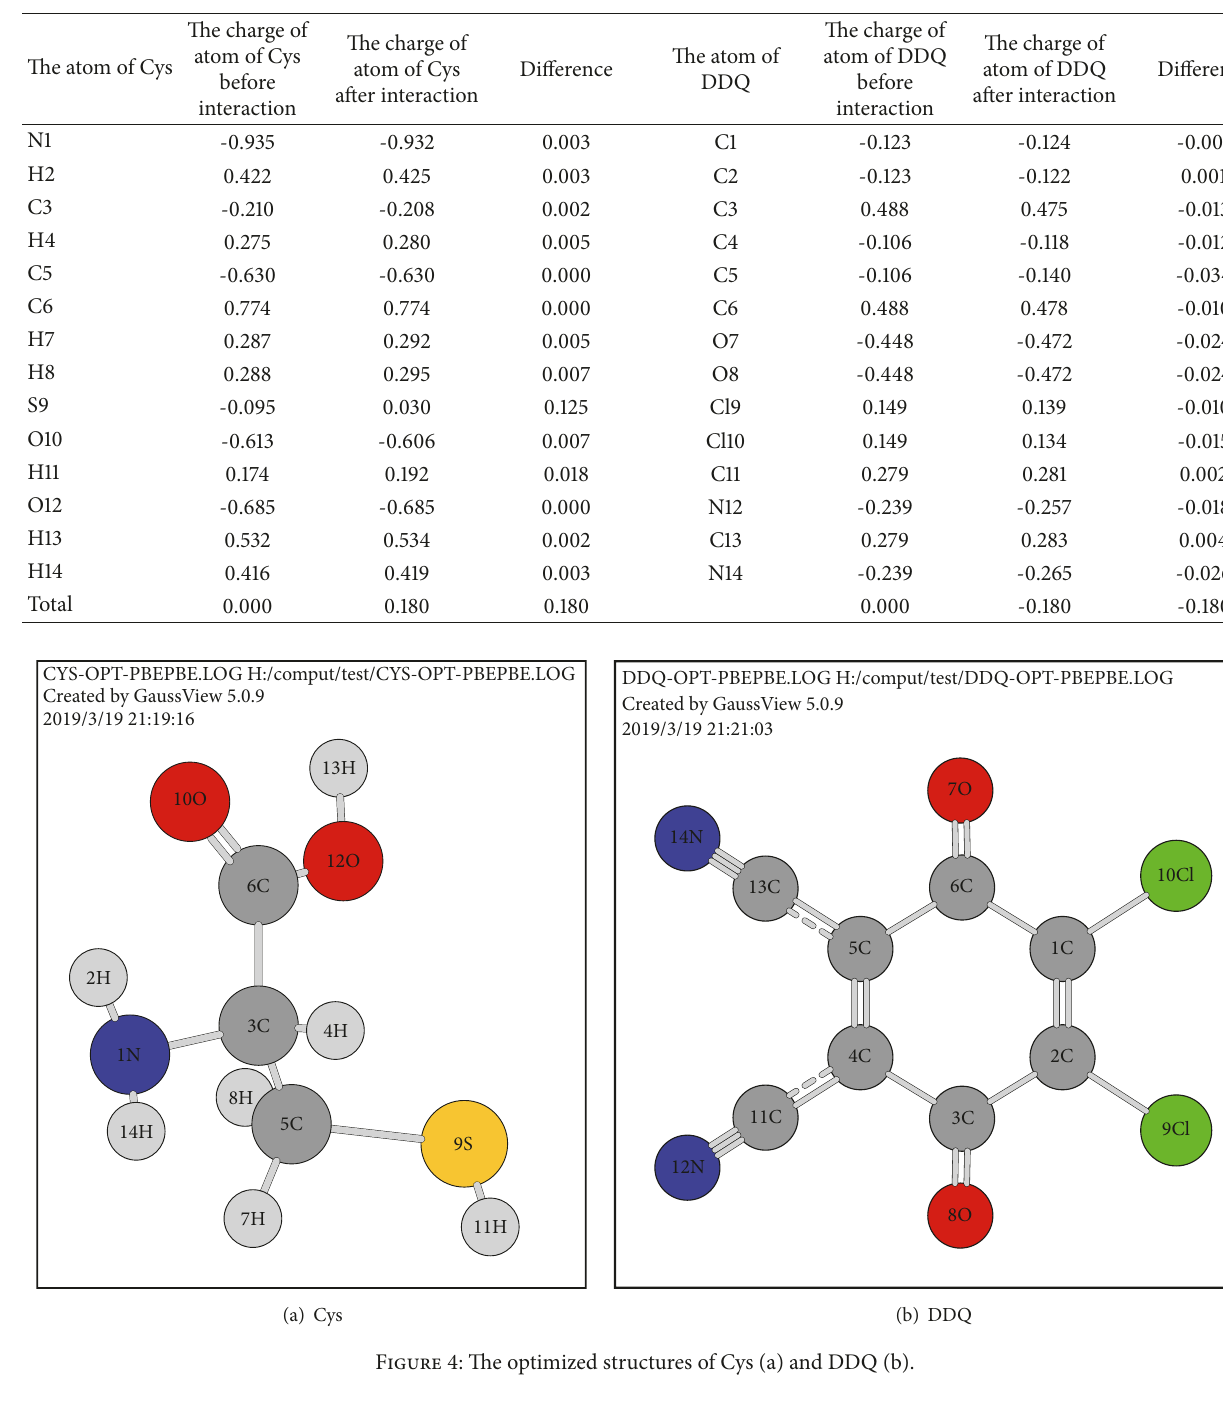
Table 2: Distribution of atomic NBO charge before and after the interaction of Cys and DDQ.